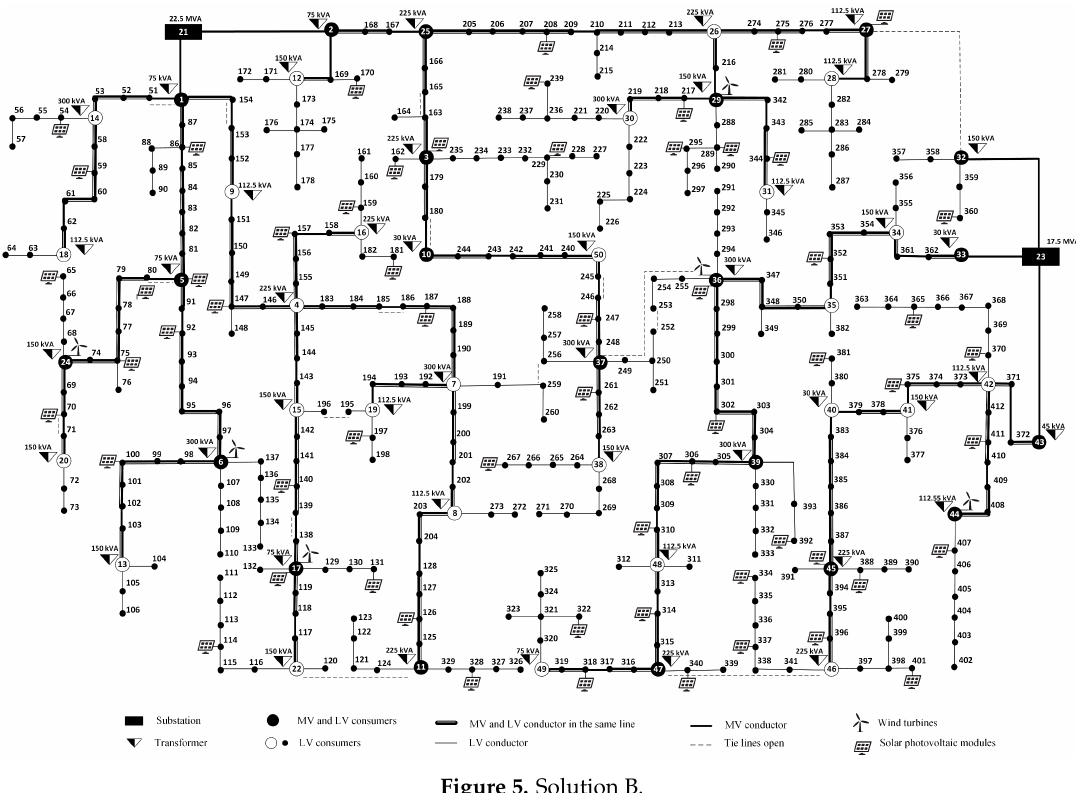
Figure 5. Solution